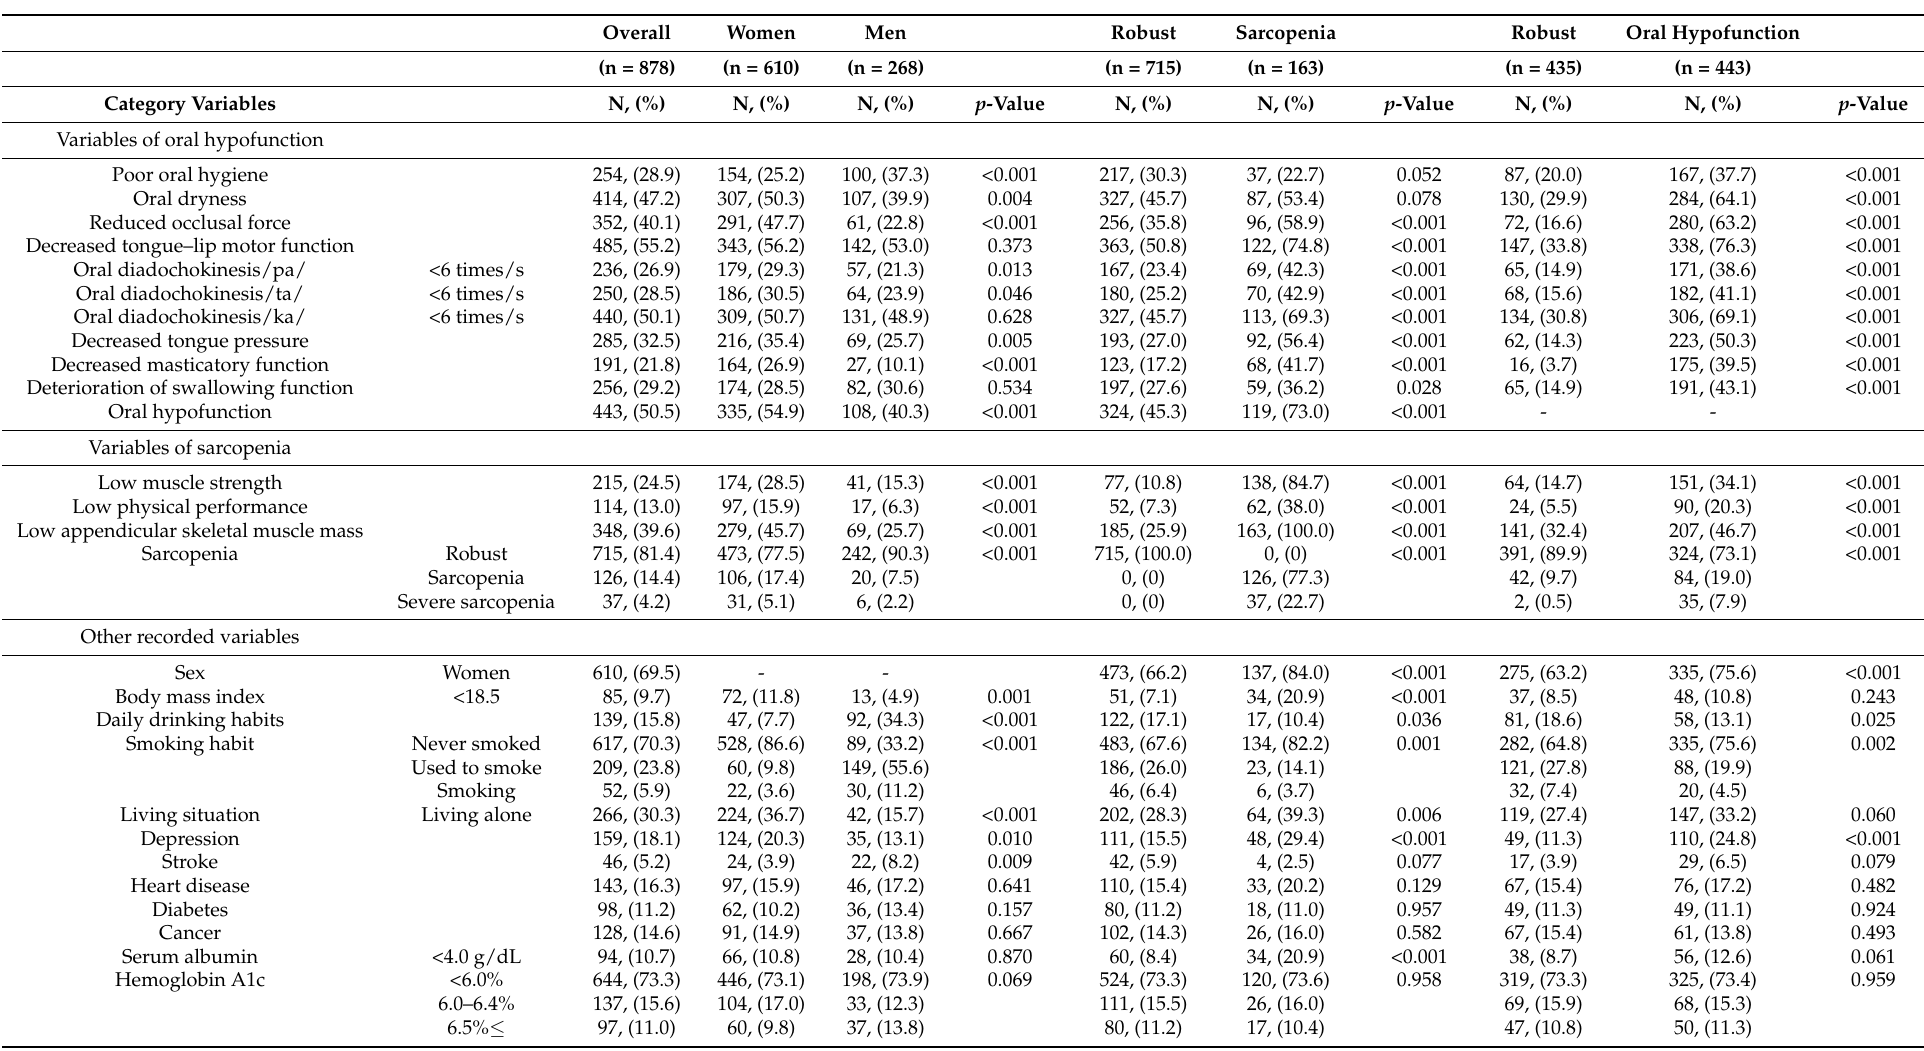
Table 2. Simple comparison of participant characteristics and categorical